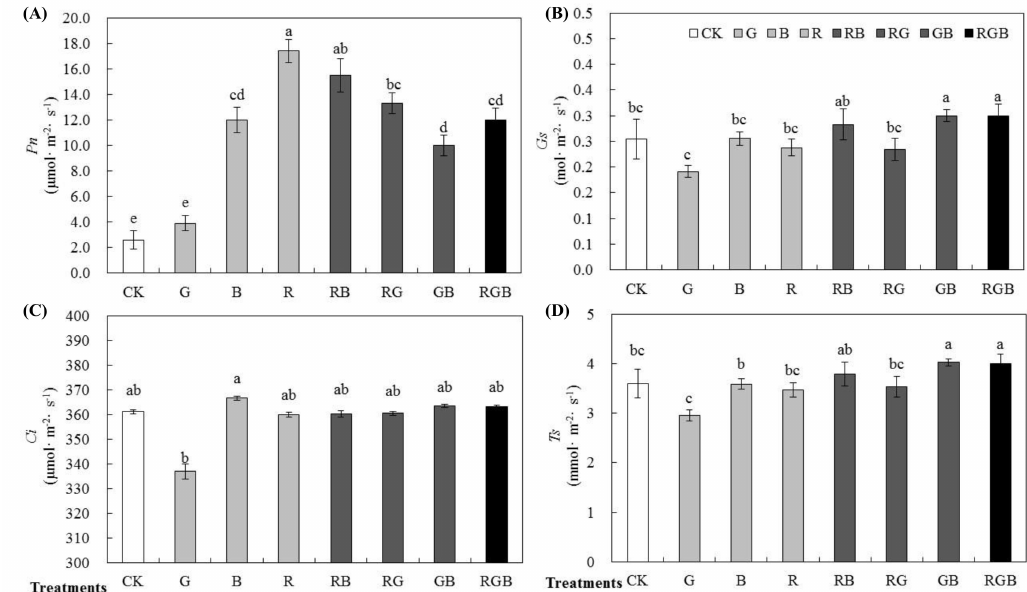
Figure 2. E ff ects of supplemental light quality on net photosynthetic rates ( A , P n ), stomatal conductance ( B , G s ), intercellular CO 2 concentration ( C , C i ), and transpiration rate ( D , T s ) of cucumber seedlings under extremely low irradiance. Di ff erent letters indicate statistically significant di ff erences among treatments ( p ≤ 0.05). Error bars show SE ( n =